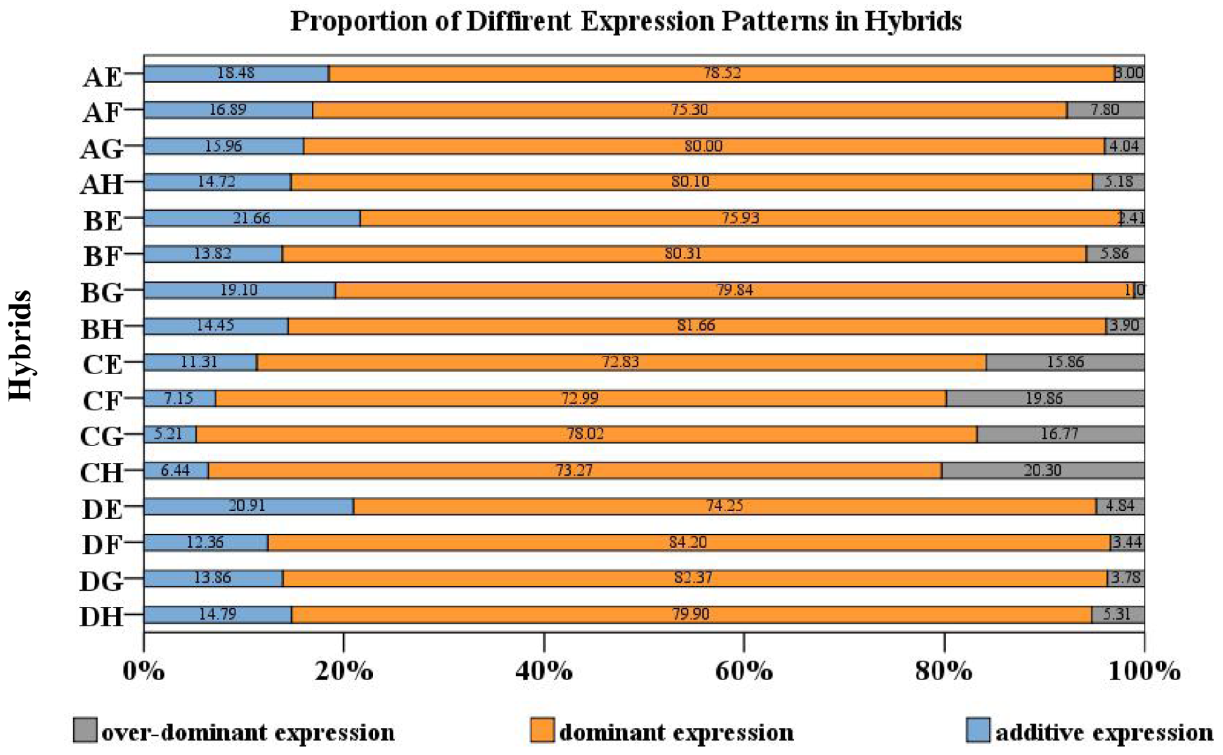
Figure 2. The percentages (%) in the graph represent the ratios ofthe additive expression pattern, dominant expression pattern and over-dominant expression pattern.